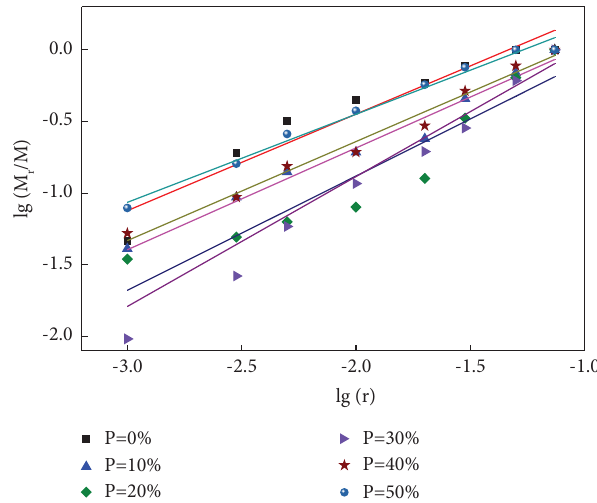
Figure 12: Te fractal dimension under the mass-equivalent size.